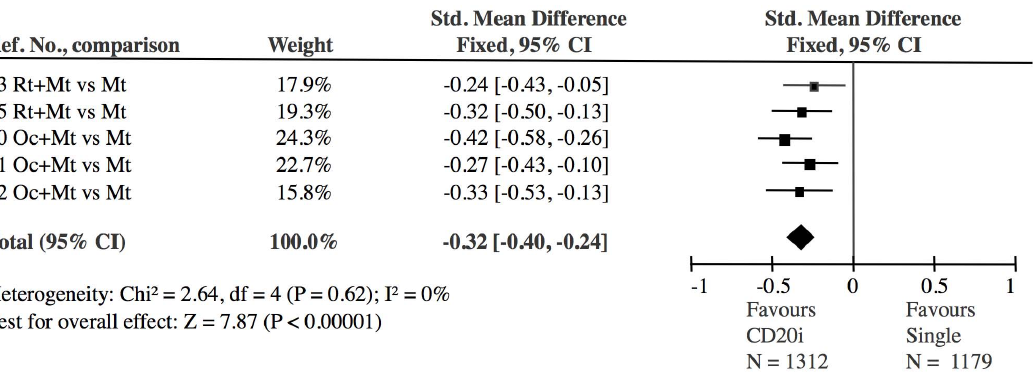
Figure 8. CD20 inhibitor treatment combined with single DMARD versus single DMARD: The effect of CD20 inhibitor treatment was highly significant (Z=7.87). The 5 CD20 inhibitor studies showed no heterogeneity (I 2 =0).